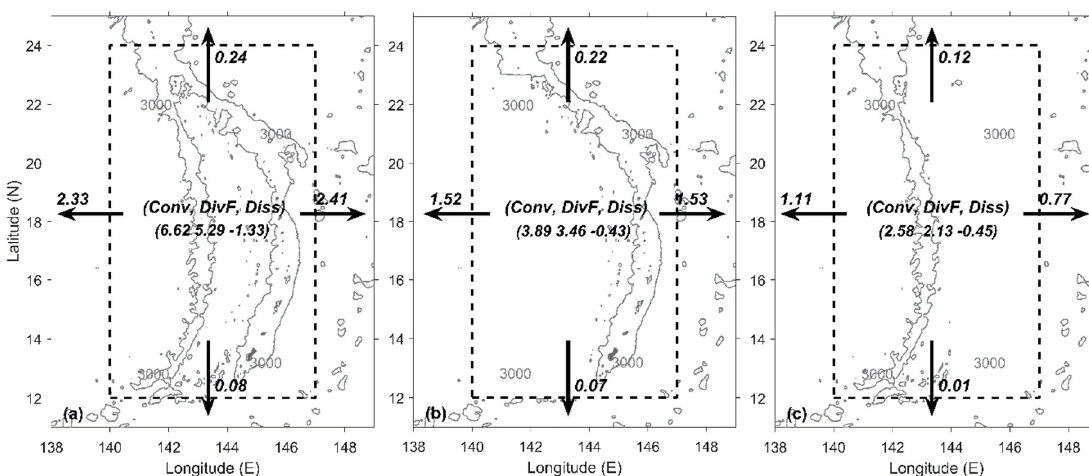
Figure 13. Diagrams of the M 2 internal tides energy budget at the Mariana Arc under the DR ( a ), SE ( b ), and SW ( c ) cases. The black dashed box bounds the integration area for our calculations. Conv, Divf, and Diss label the area-integrated conversion rate from barotropic to baroclinic tidal energy, divergence of baroclinic energy flux, and dissipation rate of the baroclinic energy (GW), respectively. The arrow crossing each dashed line represents the propagation direction of the integrated baroclinic energy on each boundary. The background contours represent the 3000-m isobaths.